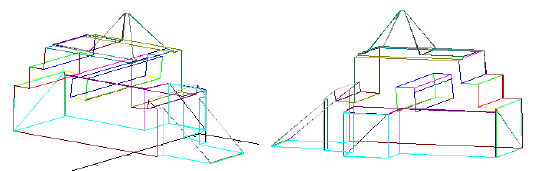
Figure 15. 3D model of structure “I”.